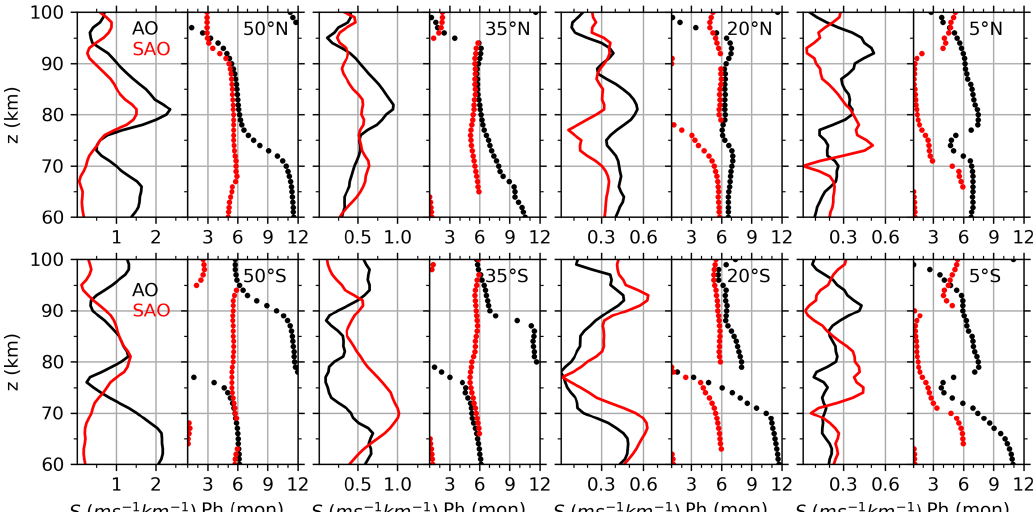
Figure 10. Amplitudes (left column of each panel) and phases (right column of each panel) of AO (black) and SAO (red) of the GW-perturbed wind shears at four latitude bands of the NH (upper row) and SH (lower row). The phase is defined as the month when the oscillation reaches its peak. Same x -axis scale is used at each latitude band. Same y -axis scale is used for all